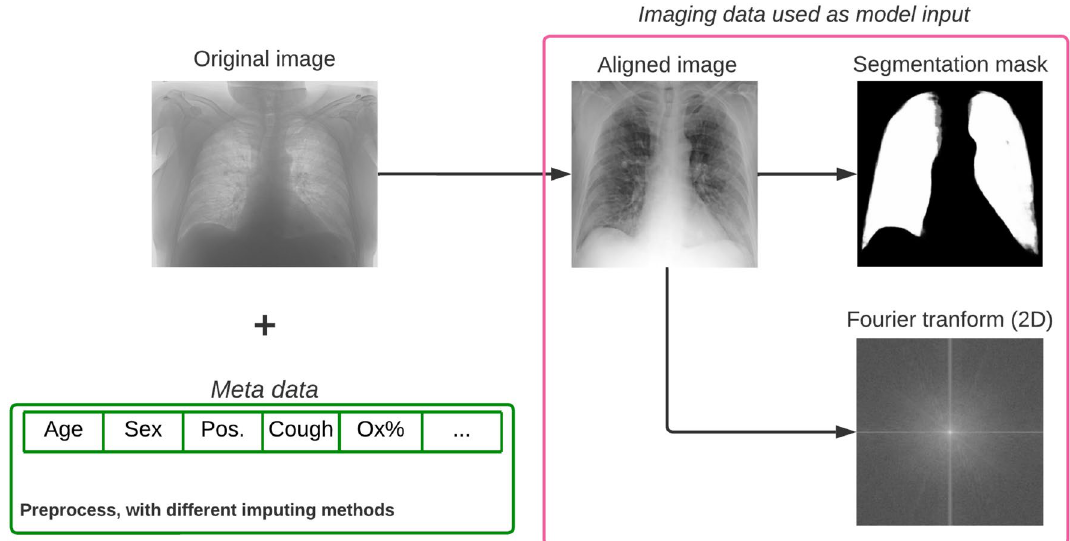
Figure 1. Original input images highly varied in brightness, contrast, pixel distribution, some were inverted and contained other artifacts. We manually checked and corrected them and also applied BSNet to align and segment them after the normalization process. The metadata was also standardized and different imputation methods were